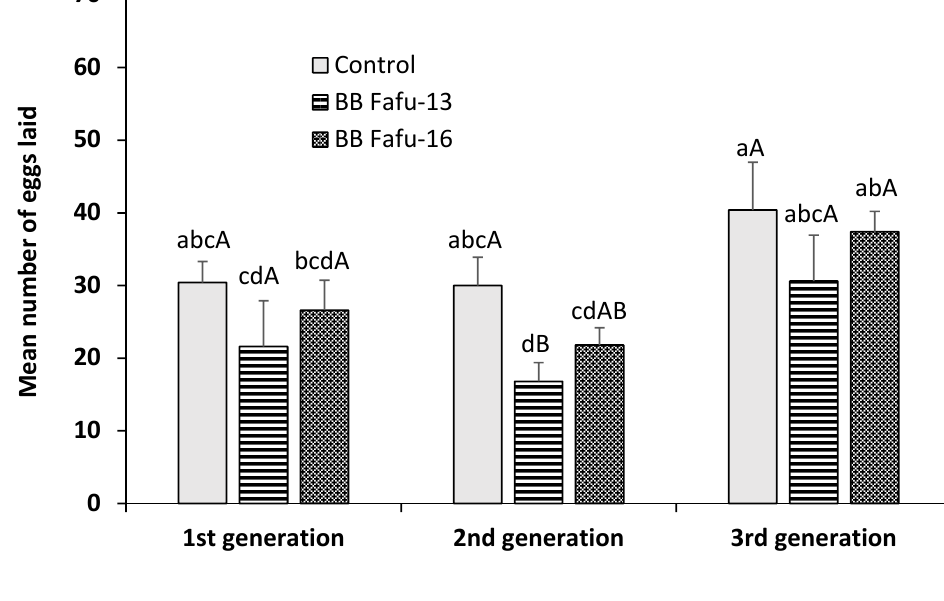
Figure 4. Mean number of eggs laid ( ± SE) by Diaphorina citri in 3 successive generations in response to treatment with Citrus limon plants challenged by endophytic Beauveria bassiana (BB Fafu-13 and BB Fafu-16) and the control. For each generation, bars ( ± SE) with di ff erent uppercase letters indicate significant di ff erences among treatments. Di ff erent lowercase letters show significant di ff erences across the generations at p = 0.05 (LSD after repeated-measures One-way ANOVA). Table 3. The effects of endophytic Beauveria bassiana isolates (BB Fafu-13 and BB Fafu-16) on the development of three successive generations of Asian citrus psyllid ( Diaphorina citri ) assessed at different days (7, 10, 14, 17, and 21 days) post exposure to endophyte-challenged Citrus limon seedlings.